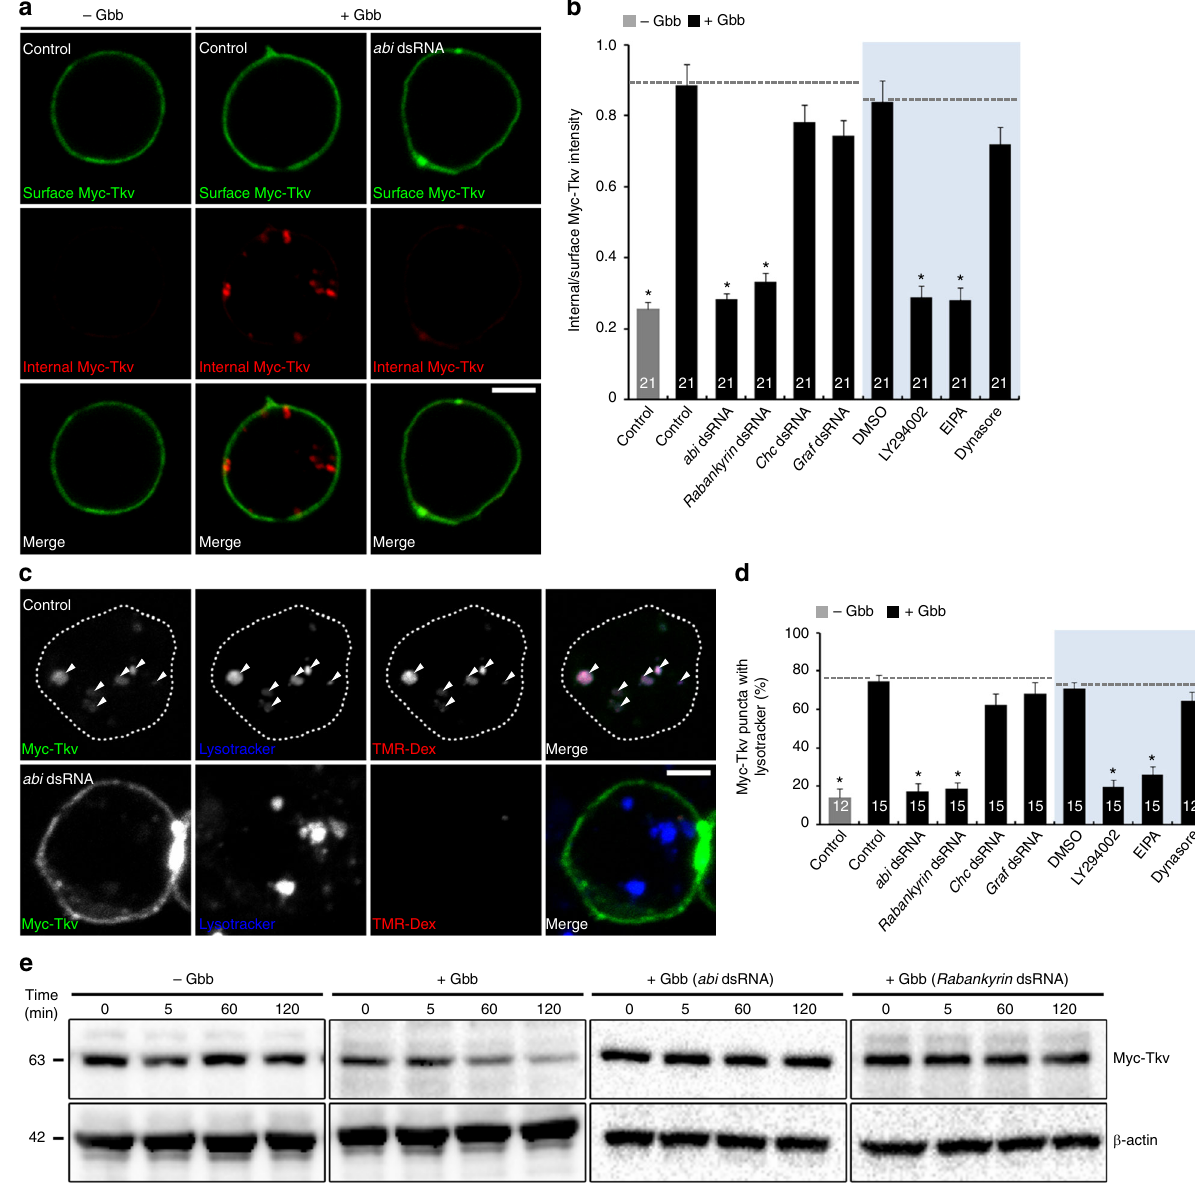
Fig. 6 Abi-dependent macropinocytosis in Gbb-induced Tkv degradation. a Gbb induces macropinocytosis-mediated internalization of Tkv receptor. Single confocal slices of BG2-c2 cells transfected with Myc-Tkv alone (control) or together with abi dsRNA. Cells were serum-starved for 6 h, prelabeled with anti-Myc antibody at 4 °C for 30 min, and then incubated in the absence ( − Gbb) or presence ( + Gbb) of Gbb at 25 °C (50 ng/ml, 5 min). After fi xing, surface and internalized receptors were sequentially fl uorescent-labeled with secondary antibodies under nonpermeant (green) and permeant (red) conditions, respectively. b Quanti fi cation of internal-to-surface Myc-Tkv ratio in controls versus cells transfected with the indicated dsRNA. Shading: BG2-c2 cells were pretreated with dimethyl sulfoxide (DMSO; 0.1%), LY294002 (25 μ M), 5- N -ethyl- N -isopropyl-amiloride (100 μ M), or dynasore (20 μ M) for 30 min. c Macropinocytosis of internalized receptors in BG2-c2 cells transfected with Myc-Tkv alone (control) or together with abi dsRNA. Serum-starved cells prelabeled with anti-Myc antibody (4 °C, 30 min) were pulsed with TMR-Dex (70 kDa, 2 mg/ml) in the absence ( − Gbb) or presence ( + Gbb) of Gbb at 25 °C (50 ng/ml, 2 min) and then chased for 18 min. Cells were labeled with Lysotracker (1 μ M, 5 min) prior to anti-Myc staining. Single confocal sections through the middle of the cells are shown. d Quanti fi cation of Myc-Tkv-Lysotracker colocalization in cells of the indicated genotypes. e Macropinocytosis mediates ligand-induced Tkv degradation. Western blot analysis of total BG2-c2 cell extracts transfected with Myc-Tkv alone or together with the indicated dsRNA. Serum-starved cells were pretreated with cycloheximide (50 μ g/ml, 3 h) to inhibit new protein synthesis and then stimulated with Gbb (50 ng/ml) at 25 °C for the indicated times. Bar graphs indicate mean ± s.e.m. The number of cells analyzed for each genotype is indicated inside bars ( b , d ). All comparisons are made against Gbb-treated (unshaded) or Gbb- and DMSO-treated (shaded) control (one-way analysis of variance with Tukey – Kramer post hoc test; * P < 0.001). Scale bars: 5 μ